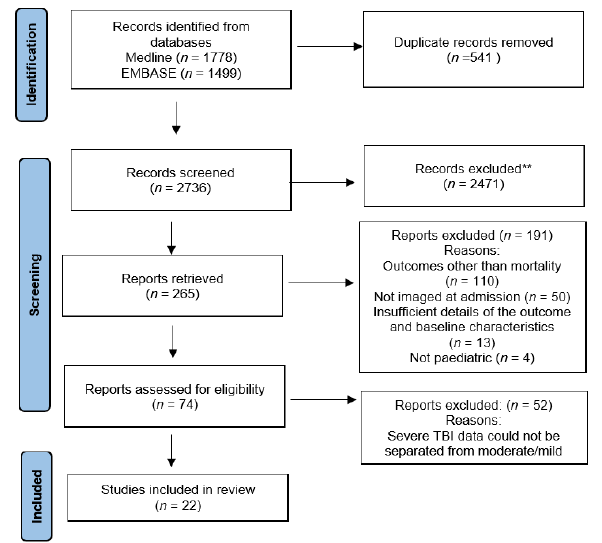
Figure 1. PRISMA flow chart. **2471 records were excluded because they met the exclusion criteria or did not include the inclusion criteria in Table 1.